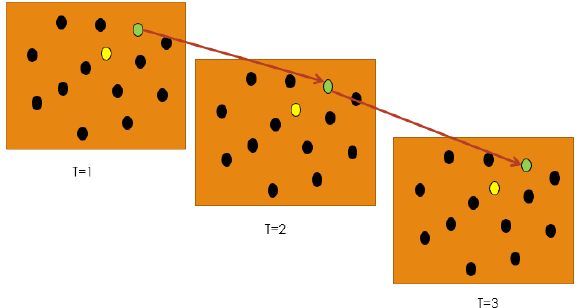
Figure 3. Robust method. The green point is the robust solution found by the method which is used in the next